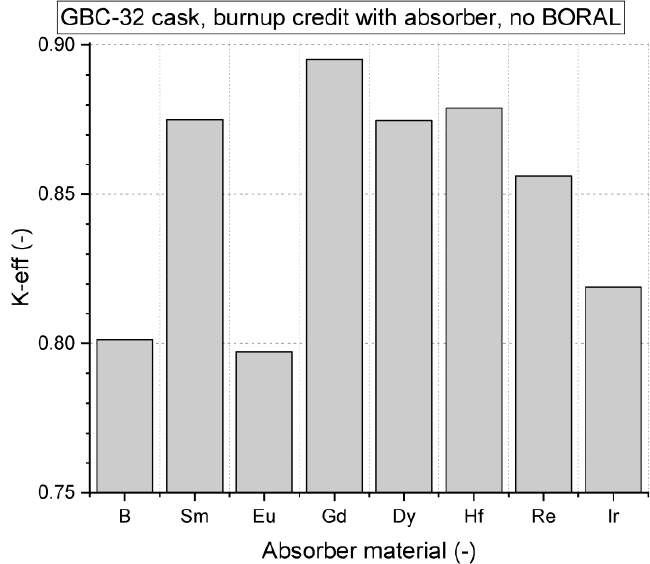
Figure 7. Burnup credit and improved absorbers for fresh fuel with lower assembly pitch.